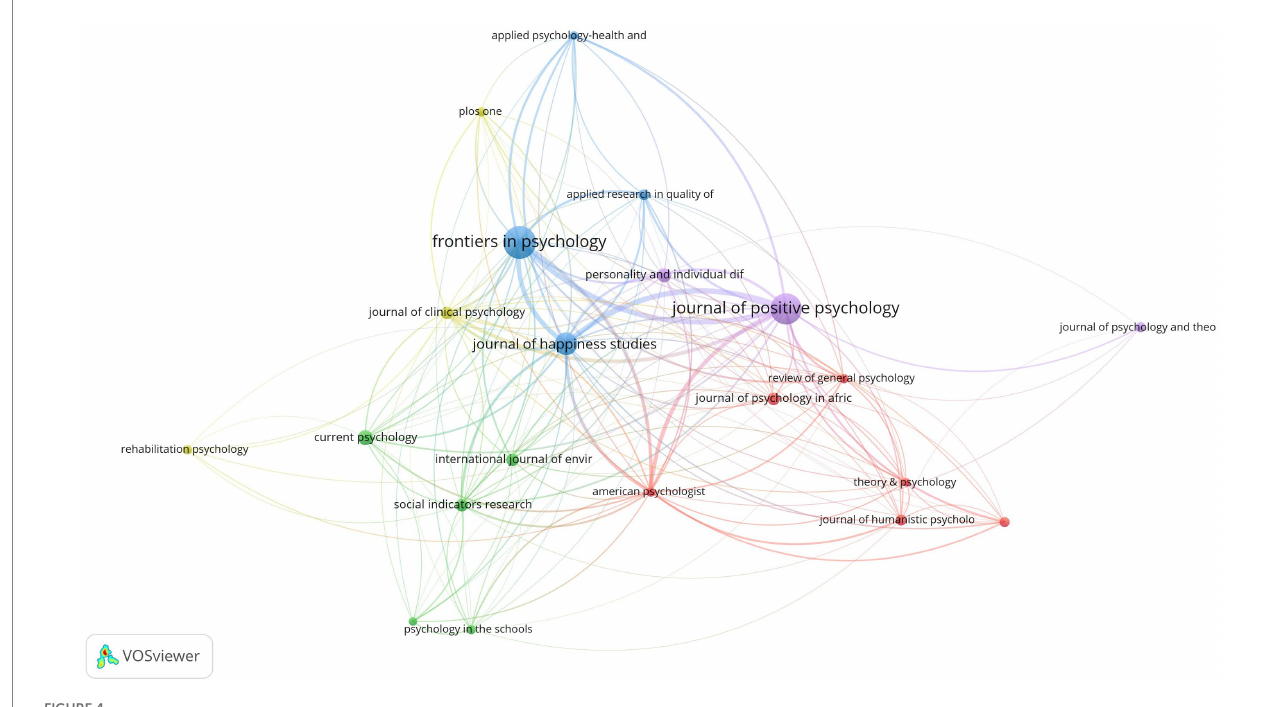
FIGURE 4 Map of journals in positive psychology research.